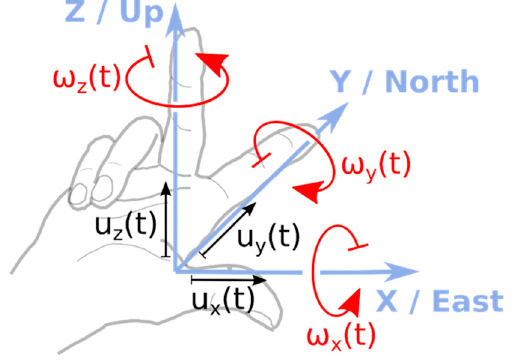
Figure 1. Six-component seismic ground motion system. The vertical rotation ω z ( t ) is often called yaw , twist , or torsion . The horizontal rotation angles ω x ( t ) and ω y ( t ) are often called rocking , roll (around the x -axis), and pitch (around the y -axis).